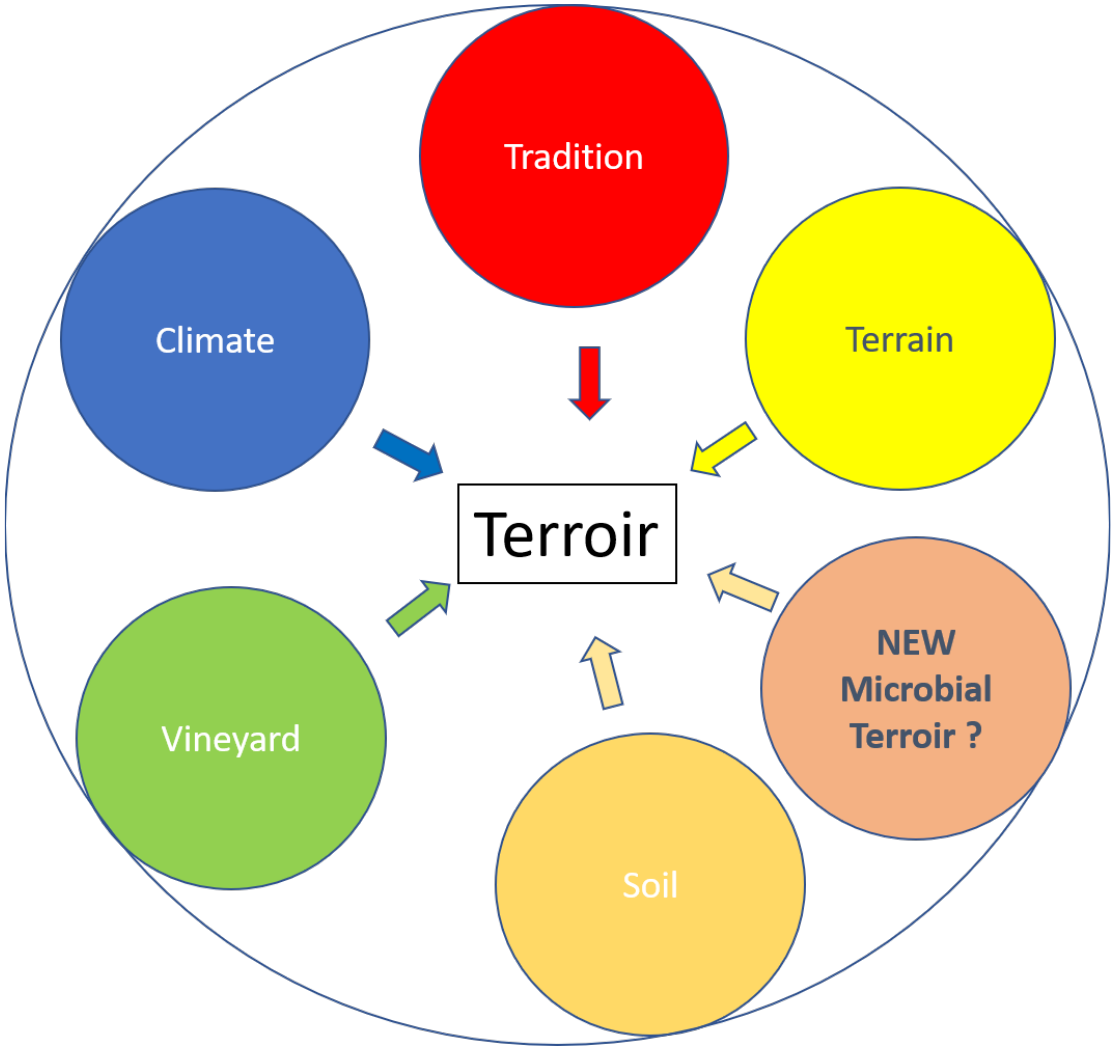
Figure 1. the components of wine terroir.